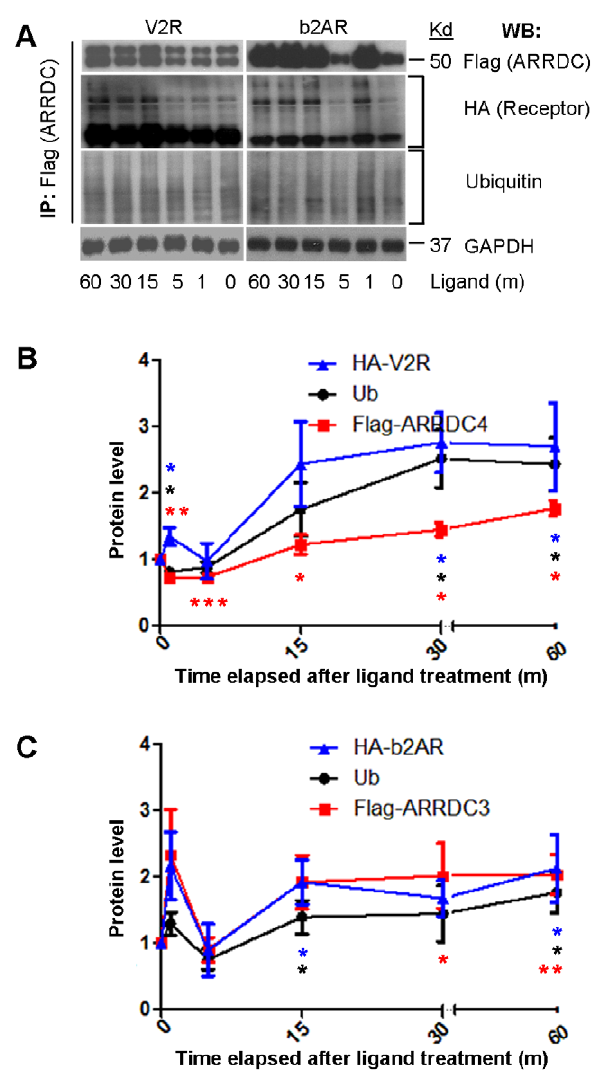
Figure 3. Time course analysis of ligand-stimulated aArrs. ( A ) HEK-293T cells were transiently cotransfected with HA-b2AR-V5 plus pBSR-ARRDC3-Flag, or HA-V2R-V5 plus pcDNA3-ARRDC4-Flag respec- tively. After 24 h incubation, cells were serum-starved and treated with 1 uM Iso or AVP for 1, 5, 15, 30, and 60 m. The cells were lysed, and lysates were immunoprecipitated (IP) and analyzed by western blot (WB). Note ARRDC4-Flag protein appears as two bands; we believe this is also the case for ARRDC4-mCherry (Fig. 2C), but that is less evident due to the large size of the fusion protein. The basis of this is not yet determined. ( B, C ) The histogram of A with mean ( + / 2 S.D.) and p- values calculated by comparing levels of ligand-treated samples with respective vector controls (paired, two-tailed t-tests from three independent experiments; ***, p , 0.001; **, p , 0.01; *p , 0.05). doi:10.1371/journal.pone.0050557.g003 proteins. [38] Two of the PY motifs are conserved in distantly related aArrs TXNIP and ARRDC2/3/4, while those of ARRDC1 have different flanking consensus sequences and locations in the tail. [15] WW domains are classified by the motif each recognizes: PPXY/LPXY (‘‘PY’’), PPLP, P/G/M-rich, phospho-(S/T)P and P/R-rich. [38,39] We used WW-domain specificities [38] to computationally identify human WW domain proteins likely to bind aArr PY motifs. That yielded , 20 proteins